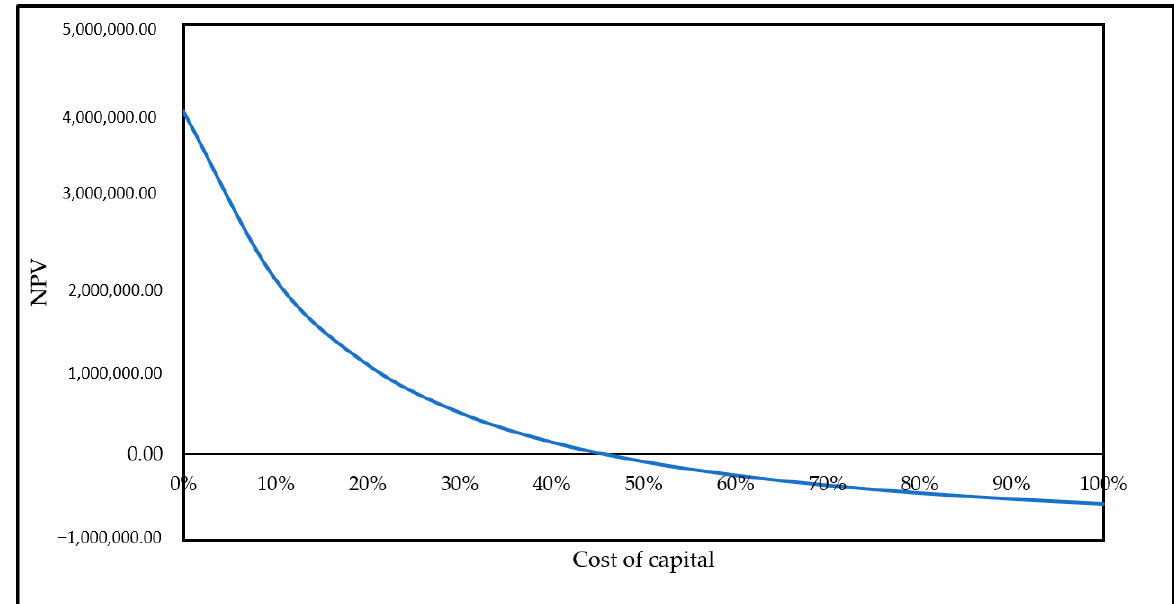
Figure 6. The IRR of the investment was more than 50% in this investigation.